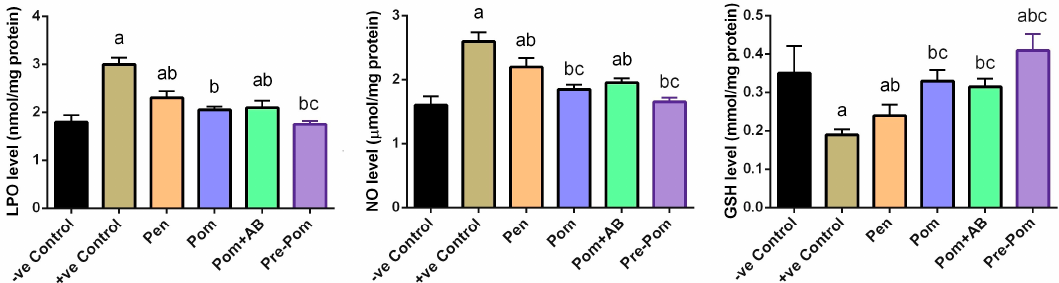
Figure 5. Effect of pomegranate juice supplementation and Pentostam treatment on oxidative stress markers in the control and experimental groups at four weeks after infection. Values are mean ± SEM (n = 10). a p < 0.05, significant change compared to the –ve Control group; b p < 0.05, significant change compared to +ve Control group; c p < 0.05, significant change compared to Pentostam group. LPO: lipid peroxidation; NO: nitric oxide and GSH: glutathione.